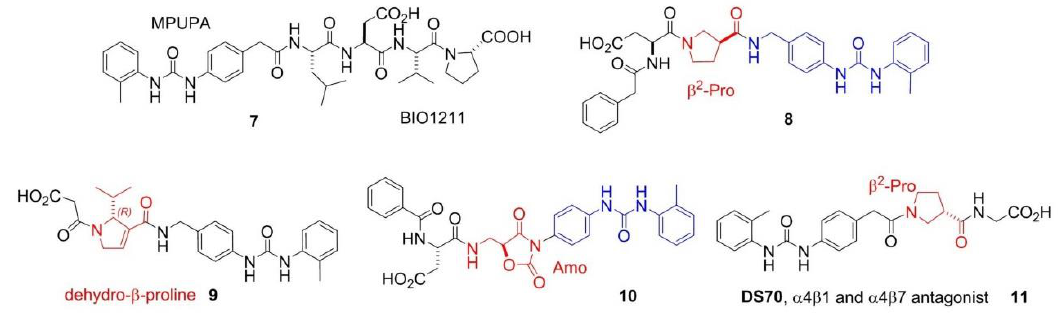
Figure 3. Examples of antagonist integrin ligands.